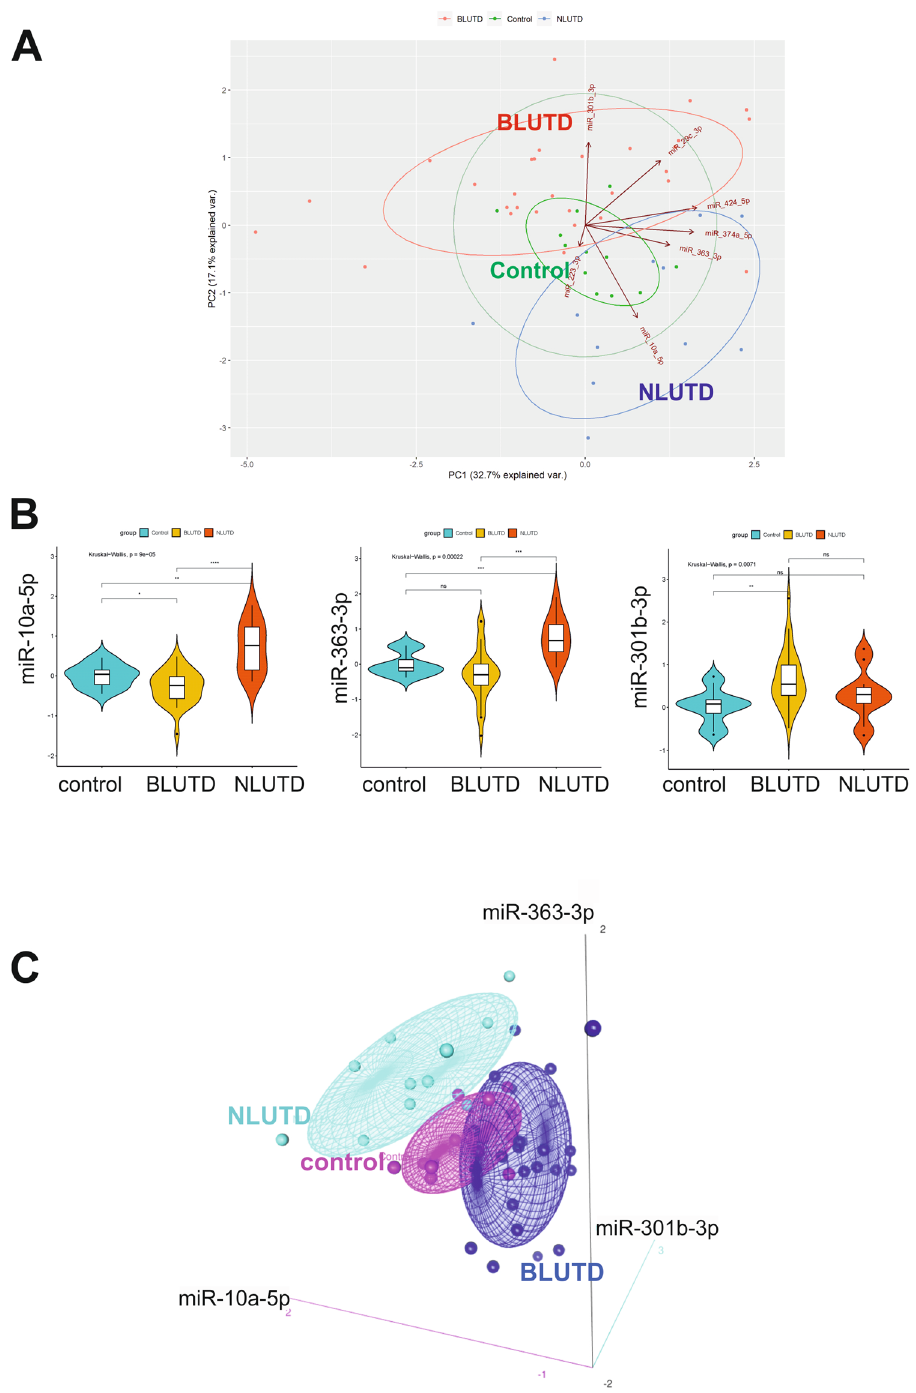
Figure 6. Identification of a three miRNA urinary biomarker signature miR-10a-5p, miR-363-3p and miR-301b-3p for obstruction- induced LUTD. (A) Principal component analysis of miRNA expression was done based on profiles of 7 miRNAs determined by RT-qPCR for each group (n = 12 controls, n = 30 BLUTD and n = 11 NLUTD). The position of patients from each group on the plot indicates the similarity of miRNA expression pattern. Controls are shown in green, NLUTD in blue, BLUTD in red. PCA confirms that NLUTD samples are well separated from BLUTD based on their miRNA profiles. In this figure, the loadings are represented by arrows. Axis PC2 has a strong negative loading for mir-10a-5p, and strong positive loadings for mir-301b-3b. Axis PC1 shows a strong positive loading for mir-363-3p. (B) Regulation of the 3 significantly changed miRNAs in urinary samples of controls and patients with BLUTD and NLUTD. RT-qPCR results in patients’ groups are shown in a violin plot as log2 fold changes compared to controls. The graph is representing minimum, first quartile, median, third quartile, and maximum. *p < 0.05 **p < 0.001 and ***p < 0.0001 (Kruskal–Wallis test). (C) Three-dimensional scatterplots and point identification for 3 miRNA urinary biomarkers for bladder outlet obstruction. Log2 fold change values of miRNAs, miR-10a-5p, miR- 301b-3p and miR-363-3p suggested by RT-qPCR validation of NanoString miRNA profiling of urinary miRNAs of patients with obstructive or neurogenic LUTD and controls are plotted. BLUTD values are shown in dark blue, NLUTD values in light blue and control values in pink. The three-miRNA signatures are sufficient to discriminate BLUTD, NLUTD and control groups from each